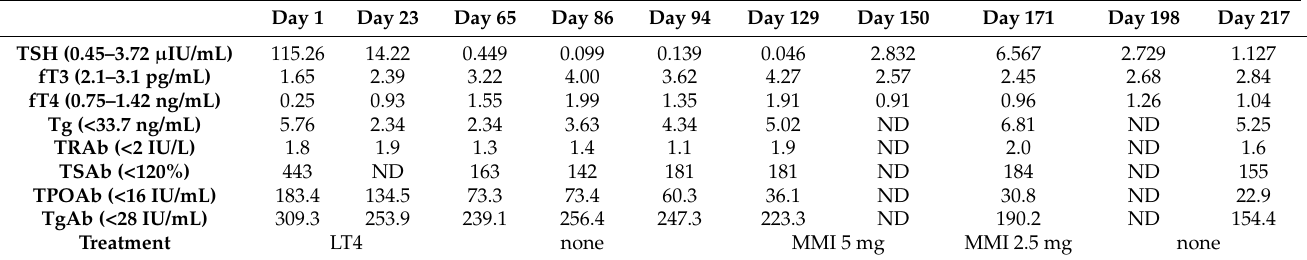
Table 2. Biochemical changes of thyroid function.